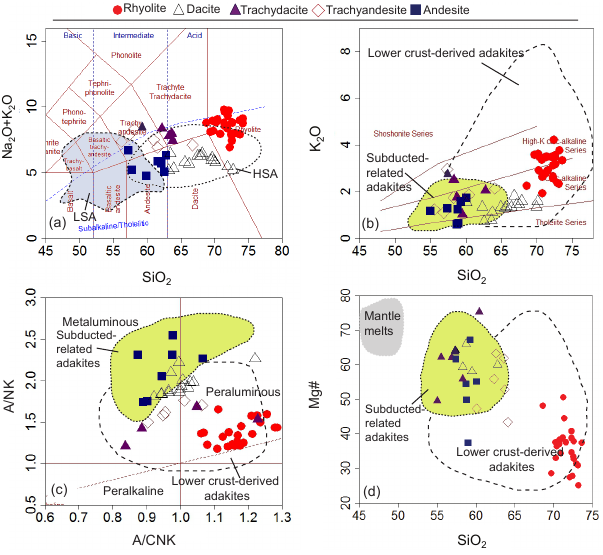
Figure 5. Selected major element plots for the subvolcanic post- ophiolite rocks. (a) Total alkalis vs. silica diagram after Le Bas et al. (1986). The boundary between alkaline and subalkaline series is after Irvine and Baragar (1971), and the fields of low-silica adakites (LSA) and high-silica adakites (HSA) are after Martin et al. (2005). (b) K 2 O vs. SiO 2 diagram (after Peccerillo and Taylor, 1976); (c) A/CNK vs. A/NK diagram (Maniar and Piccoli, 1989); (d) Mg# vs. SiO 2 diagram. The fields of subduction-related adakites and lower crust-derived adakites are from Guan et al.